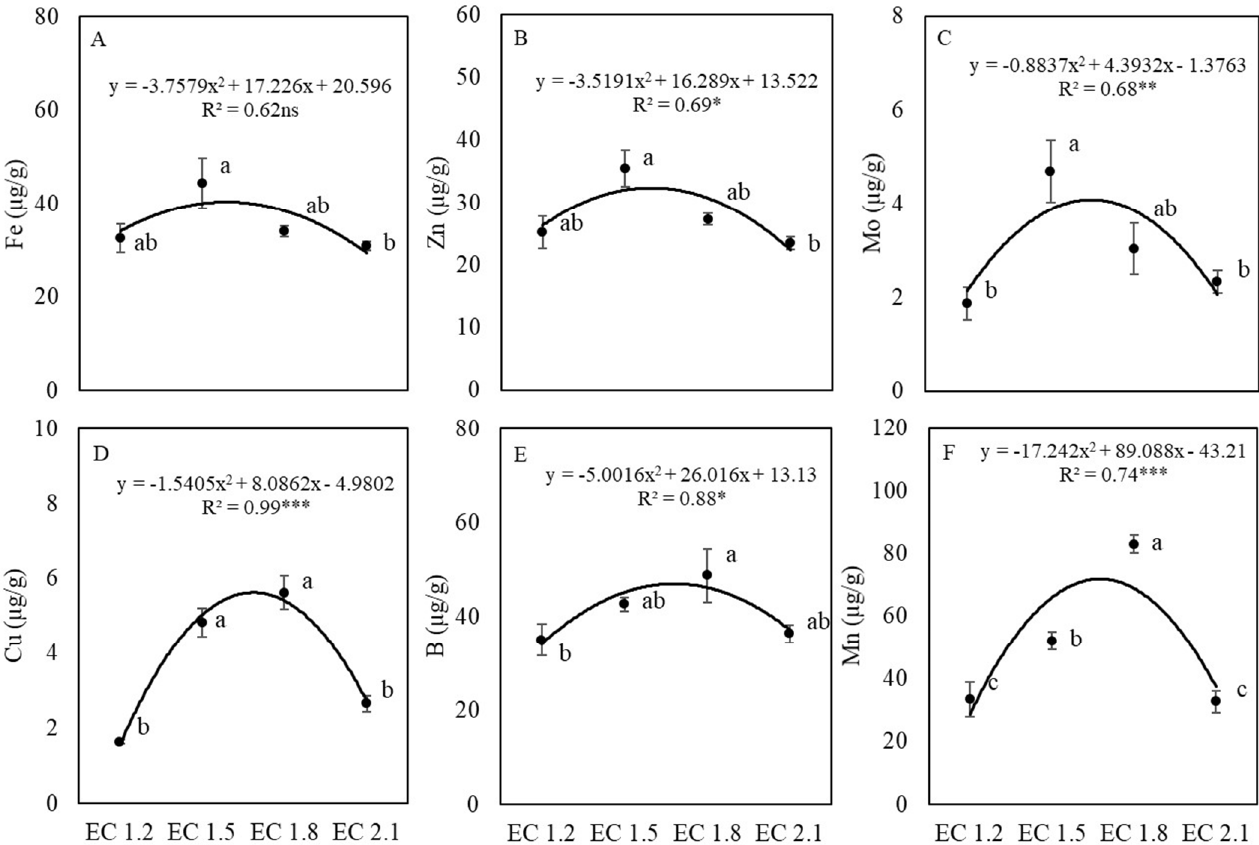
Figure 9. Effect of electrical conductivity (EC) of nutrient solution on arugula micro nutrition contents of ( A ) iron, ( B ) zinc, ( C ) molybdenum, ( D ) copper, ( E ) boron and ( F ) manganese in the shoot part of arugula 4 weeks after transplanting into a nutrient-film technique hydroponic system containing nutrient solutions with EC of 1.2, 1.5, 1.8, or 2.1 dS·m − 1 . Data points with different letters are significantly different according to Tukey’s test ( α = 0.05). Error bars represent the standard errors ( n = 32). ns, *, ** or *** indicate no significance or significance at P of 0.05, 0.01 or 0.001, respectively. Although there was no significant difference in nitrate concentration between EC 1.8